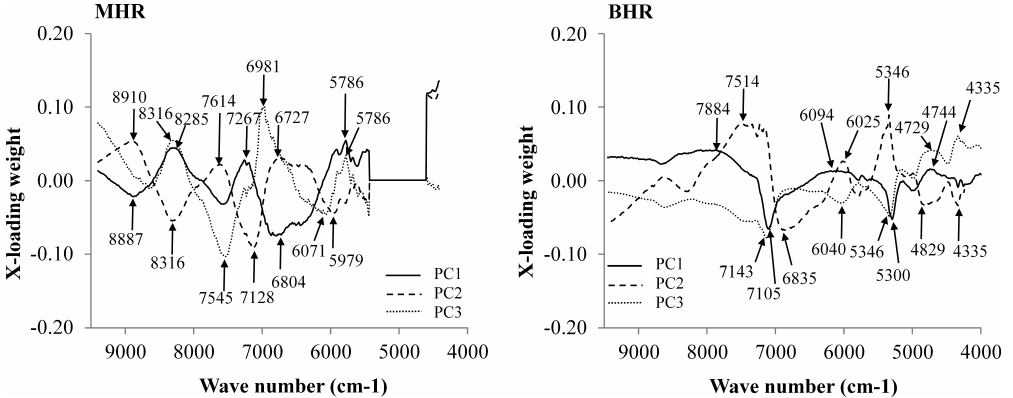
Fig. 7. X-Loading weight plots of the validated models for DRW prediction in MHR (left) and BHR (right) samples.